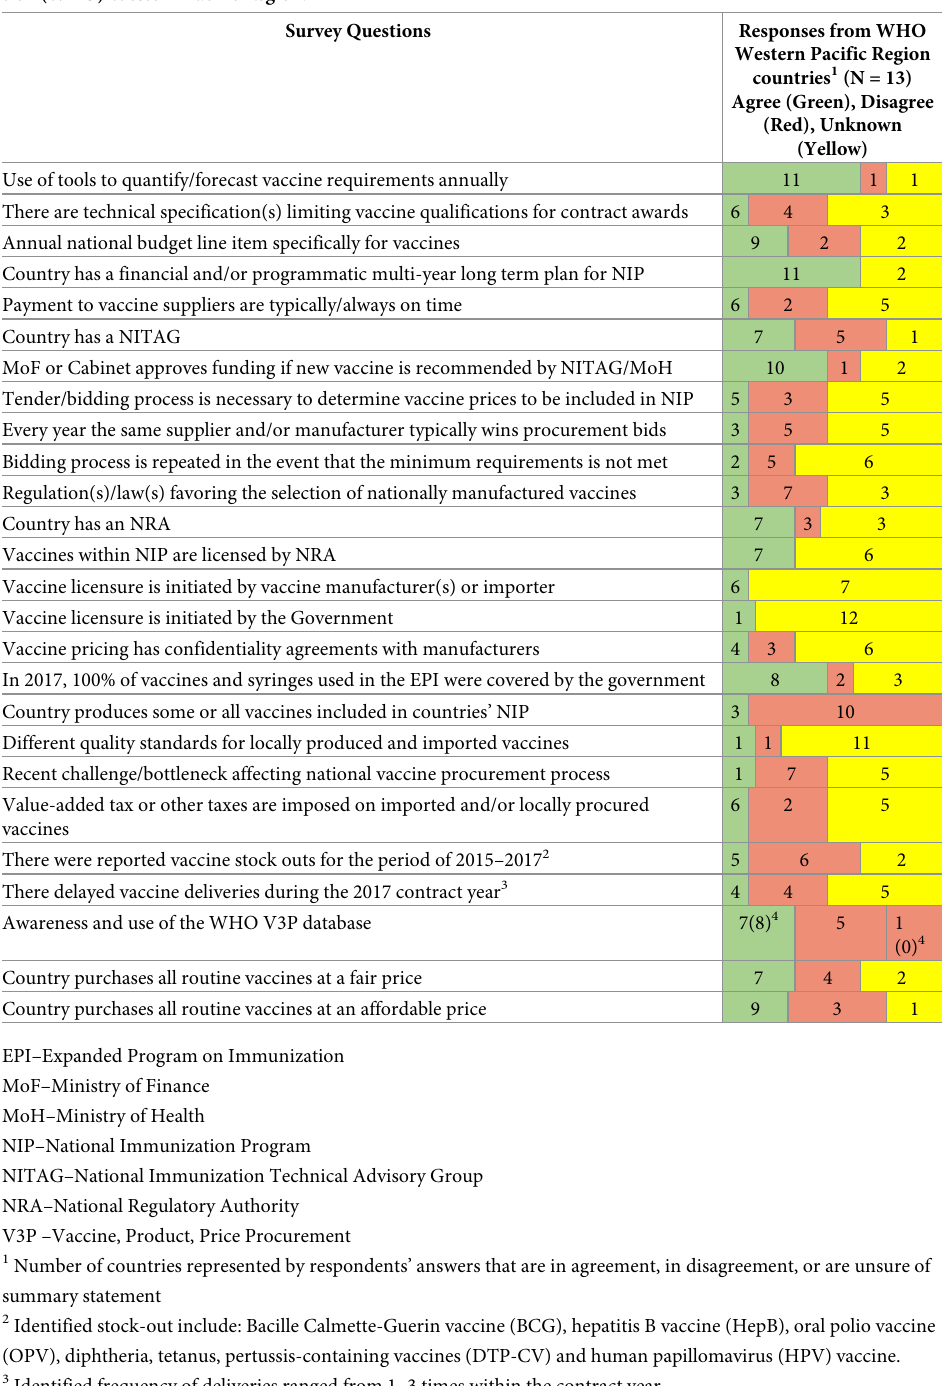
Table 1. Summary of responses related to country-specific procurement processes in the World Health Organiza- tion (WHO) Western Pacific